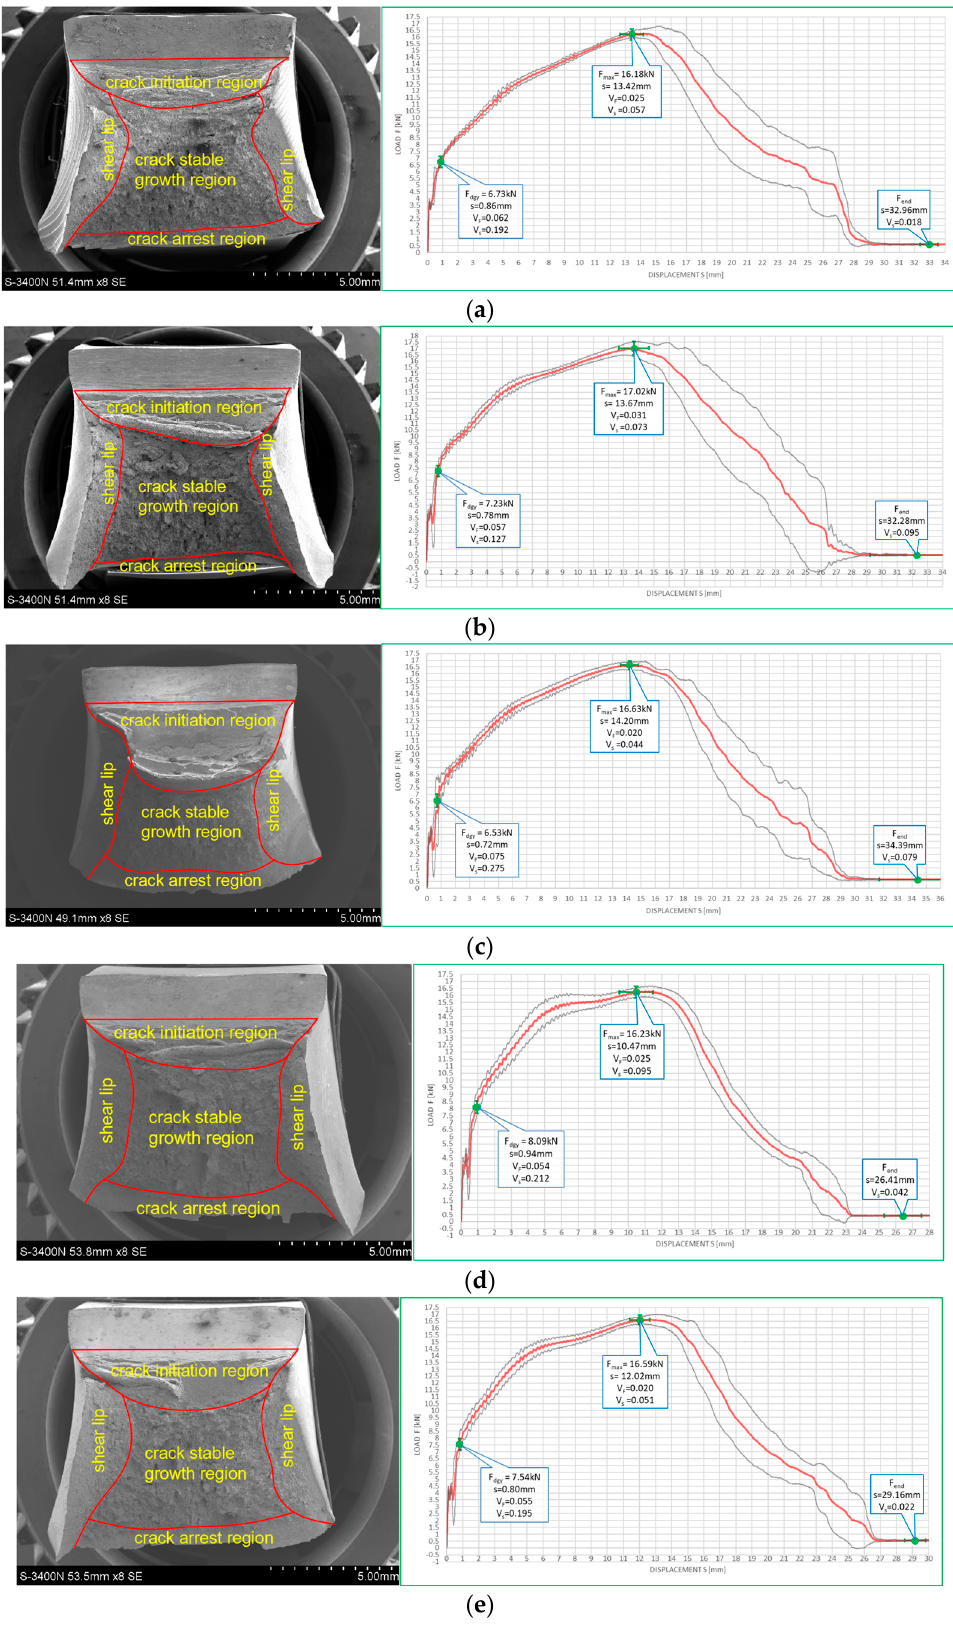
Figure 18. Morphology of the impact fractures obtained during the tests conducted at +20 °C on the samples made of X6CrNiTi18-10 steel—denotations follow the key listed in Table 1. ( a ) 3 (+20) ; ( b ) 360 (+20) ; ( c ) 361 (+20) ; ( d ) 380 (+20) ; ( e ) 381 (+20) .